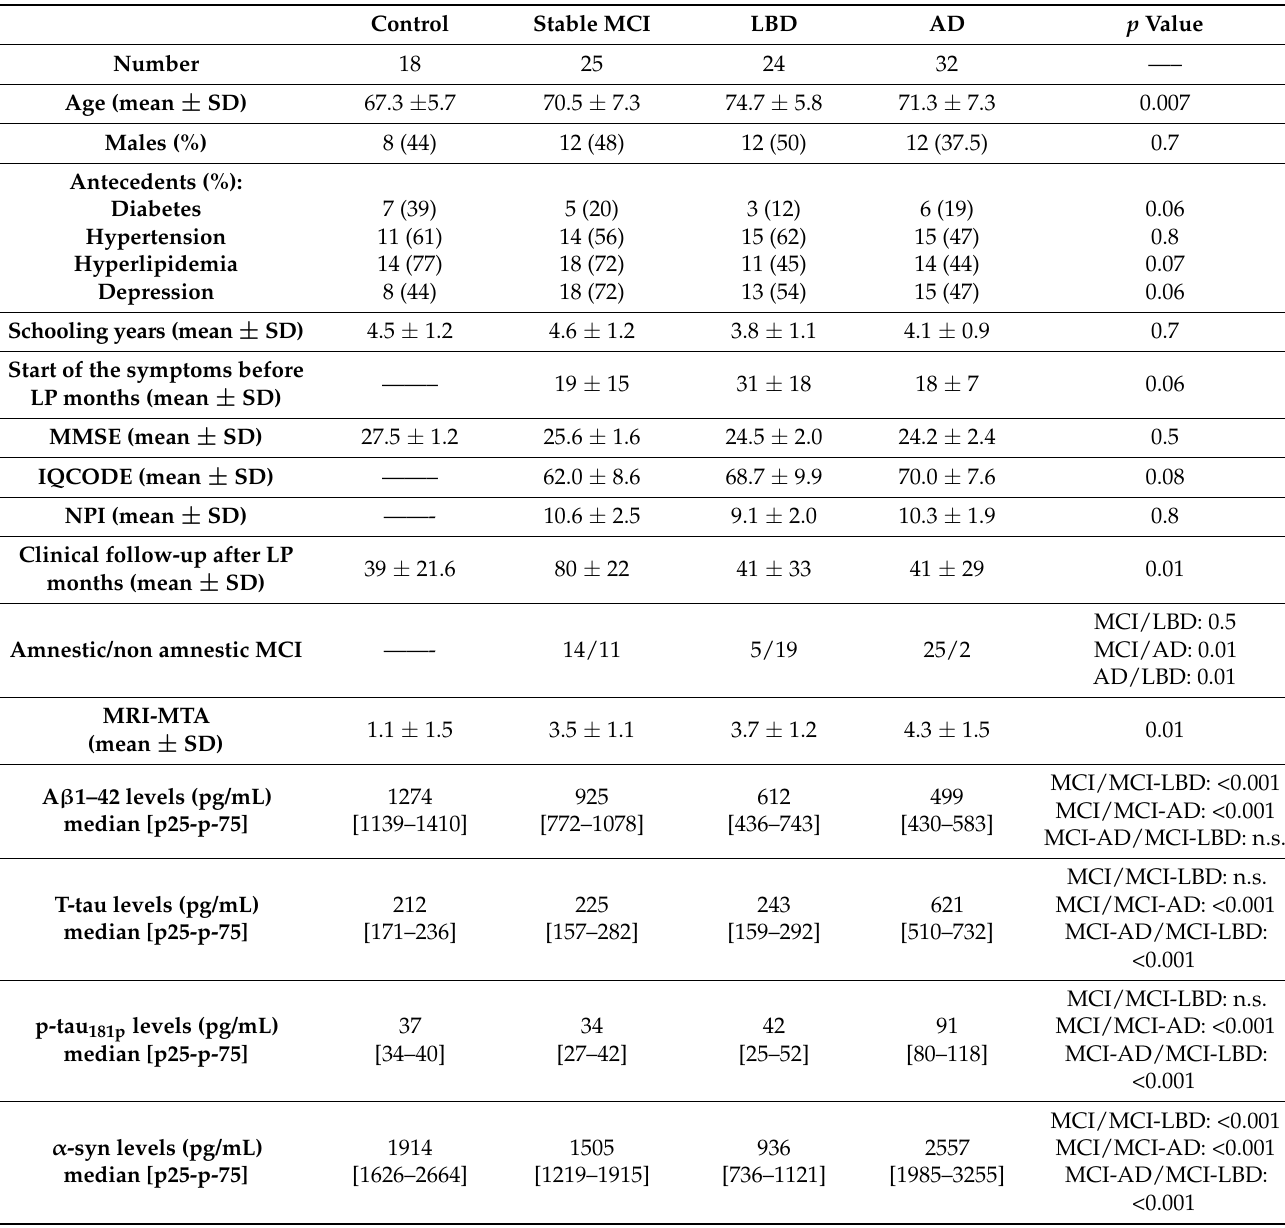
Table 1. Clinical, demographic characteristics and levels of CSF biomarkers in the AD, LBD, stable MCI and control groups.